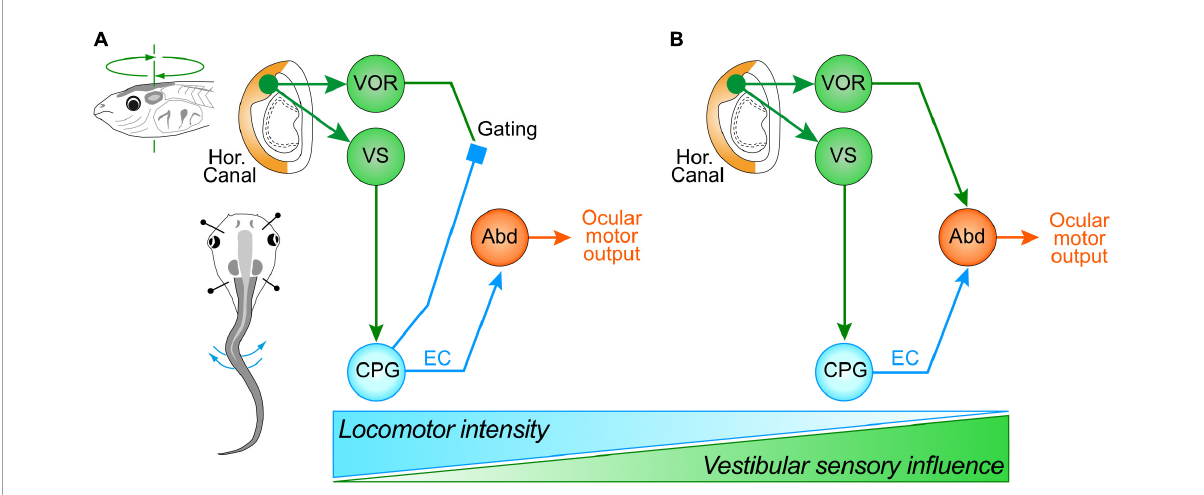
FIGURE4 Differential swim intensity-dependent interactions between vestibular sensory signals and locomotor ECs. (A) Schematic depicting the gating of vestibulo-ocular signaling during intense swimming in older larvae or in rapidly-swimming young larvae, leading to ocular motor performance remaining coordinated with tail undulations exclusively through an ascending drive from spinal ECs; during less intense or slow swimming (B) , ocular motor performance results from an additive relationship between the predictive ECs and horizontal semicircular canal signals, with the latter now contributing significantly to compensatory eye motion; the two processing configurations gradually change their respective dominance depending on swimming strength and frequency (bottom schematic). Abd, abducens motoneurons; CPG, central pattern generator; VOR, vestibulo-ocular reflex; VS, vestibulo-spinal